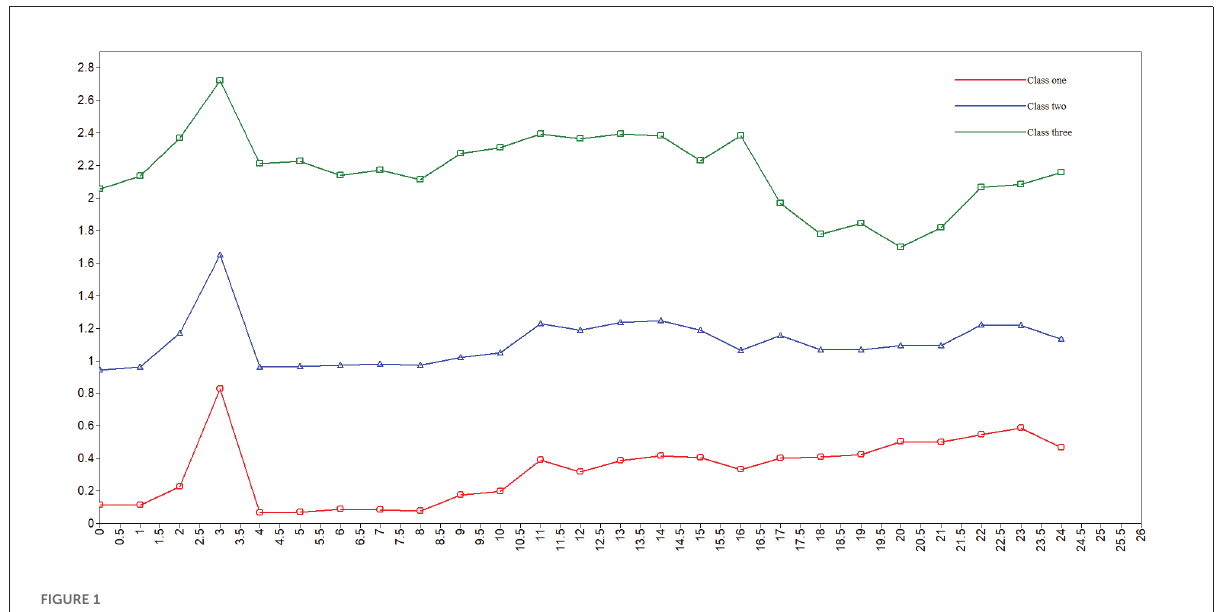
FIGURE1 The distribution of three potential classes of social